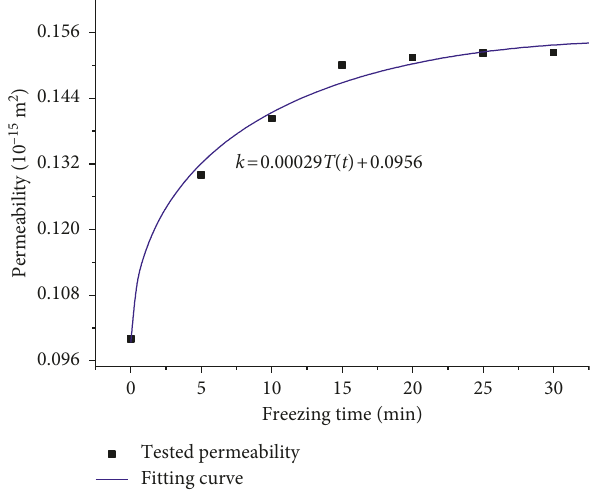
Figure 8: Linear fit of temperature drop and permeability.